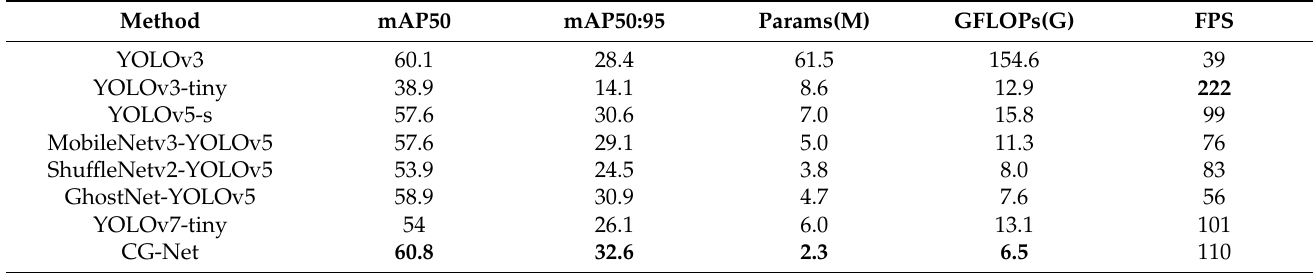
Table 6. Comparison with state-of-the-art methods on the NEU-CLS dataset.